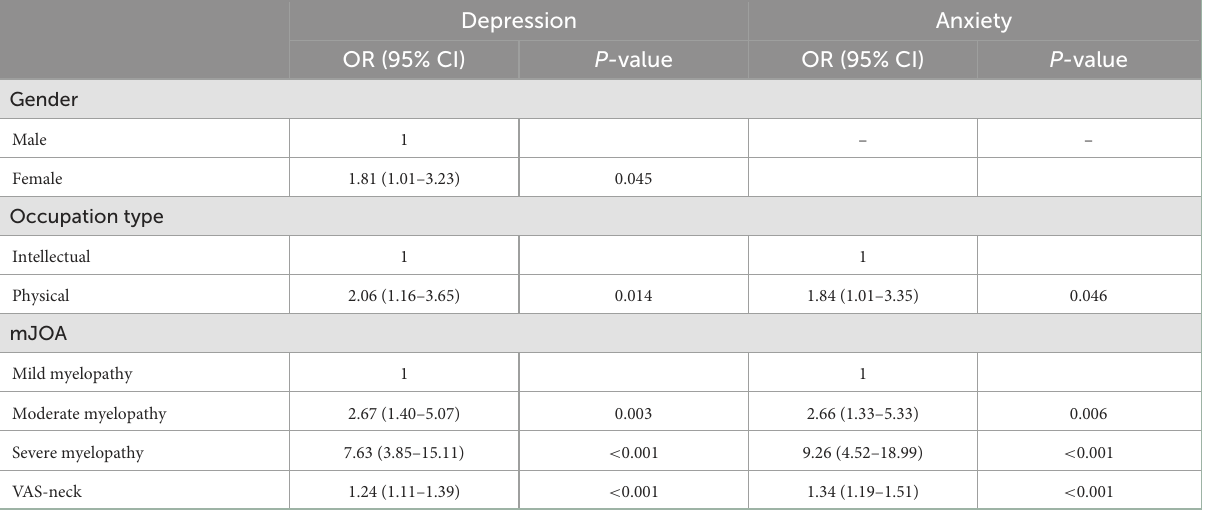
TABLE 3 Multivariate logistic regression analysis of patient